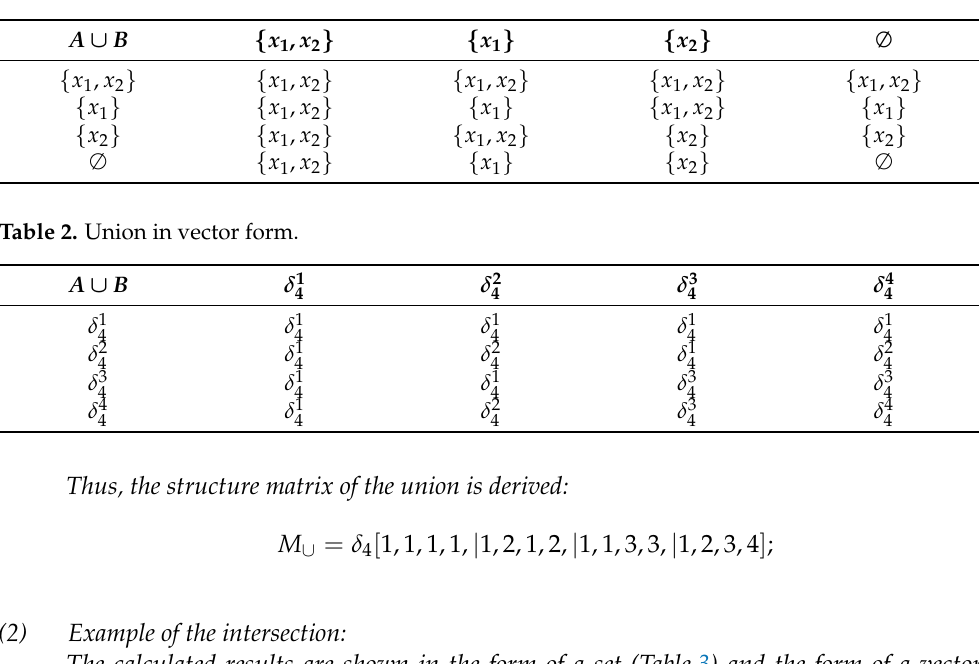
Table 1. Union in set form.